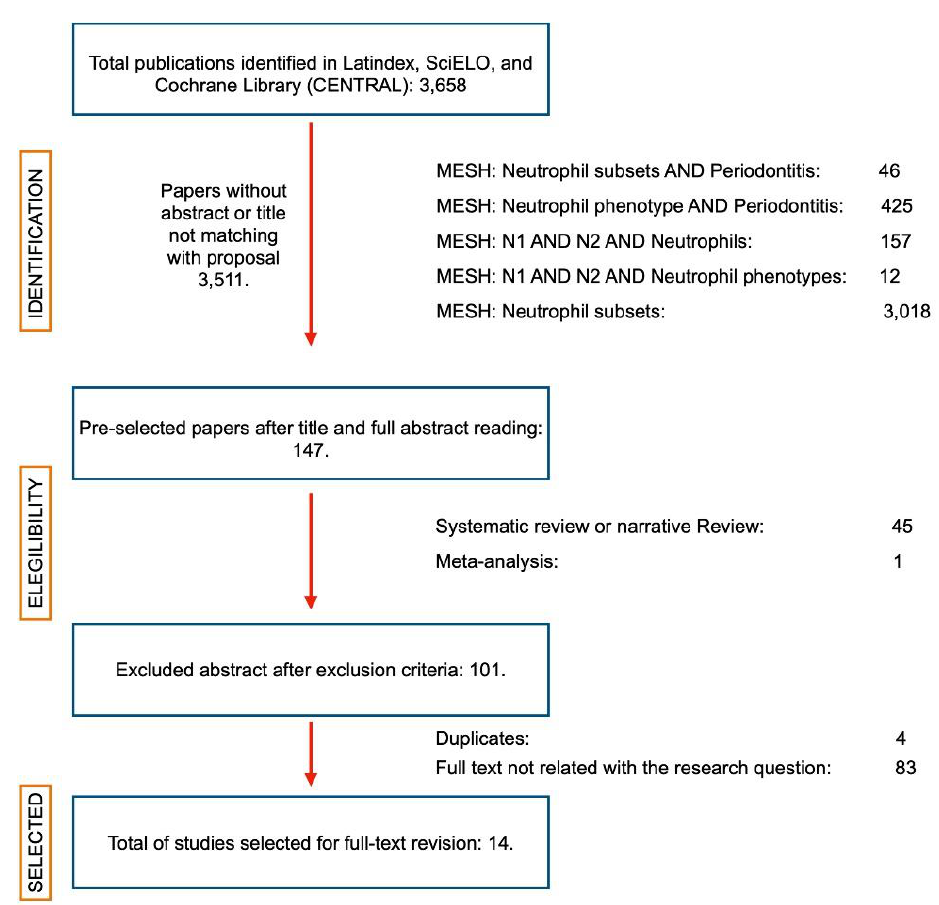
Figure 1. PRISMA flow diagram. Summary of the article search. From a universe of 3658 articles, 147 passed the first review of abstract and title. Subsequently, systematic reviews with or without meta-analysis and narrative reviews were eliminated until 101 articles remained, which were re- viewed in full-text format. Finally, 14 articles were selected to prepare this systematic review. (Created with http://biorender.com, accessed on March 2020). Table 1. Data extracted after individual analysis. Population, concept, and context individualiza- tion.